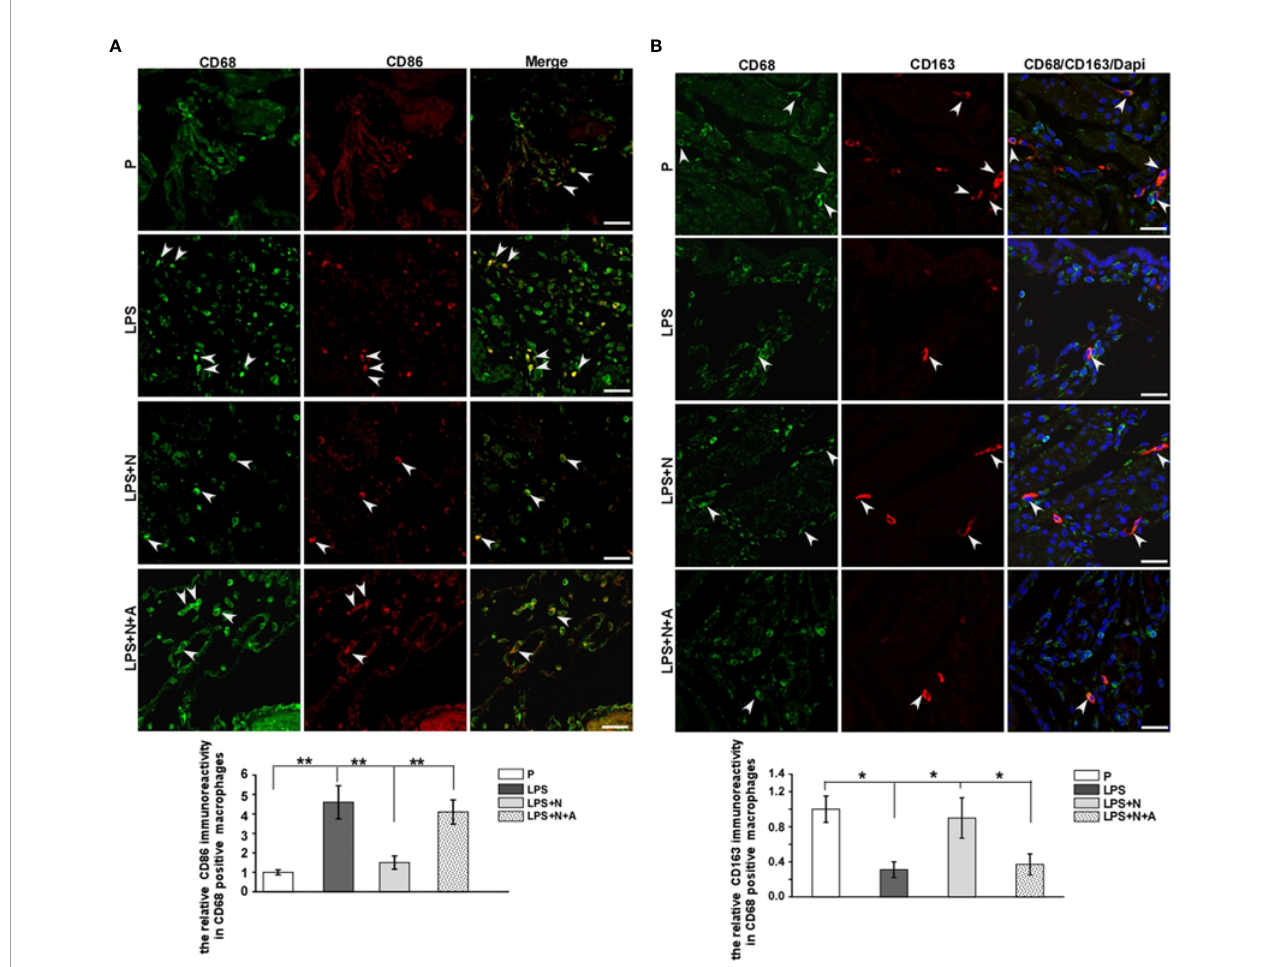
FIGURE 8 | Immuno fl uorescent staining results showed that nicotine differentially affected the expression of decidual macrophage M1 and M2 biomarkers in PE-like mice. (A) Immunostaining of CD86 and CD68 in the decidua from all animal groups and bar graph showed quantitative analysis results on CD86-positive immunoreactivity in dM j . White arrow heads showed colocalization of dM j with CD86. Scale bar=30 m m. **P < 0.01. (B) Immunostaining of CD163 and CD68 in the decidua from all animal groups and bar graph showed quantitative analysis results on CD163-positive immunoreactivity in dM j . White arrow heads showed colocalization of dM j with CD163. Scale bar=30 m m. *P < 0.05 and **P <